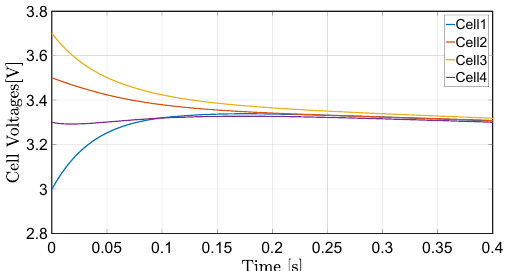
Figure 7. Cell voltage vs. time of the buck-boost balancing circuit.